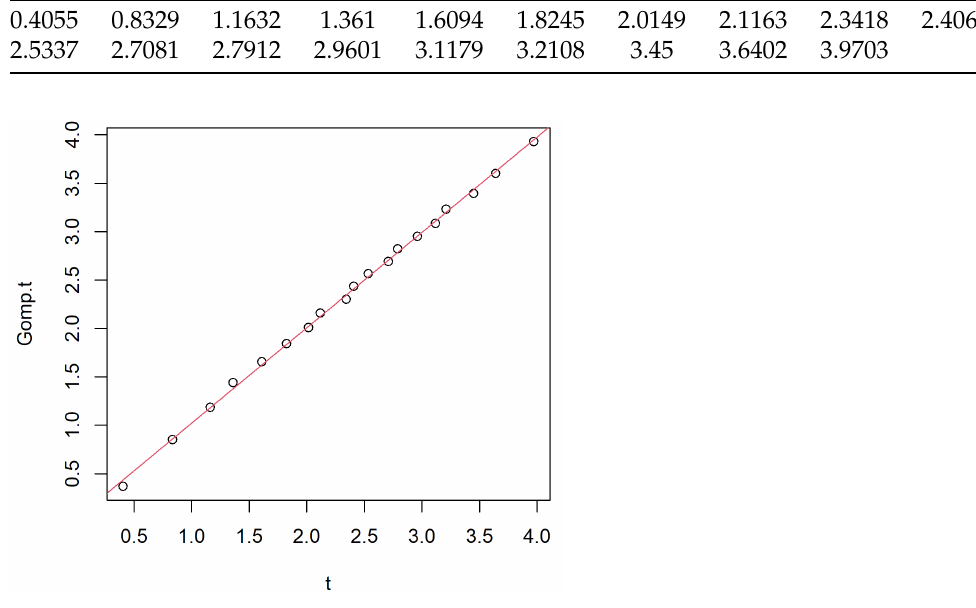
Figure 4. The quantile-quantile (QQ) plot of the logarithm-transformed first failure time of small electric carts with the quantiles of Gomp. t j , j = 1,2, · · ·